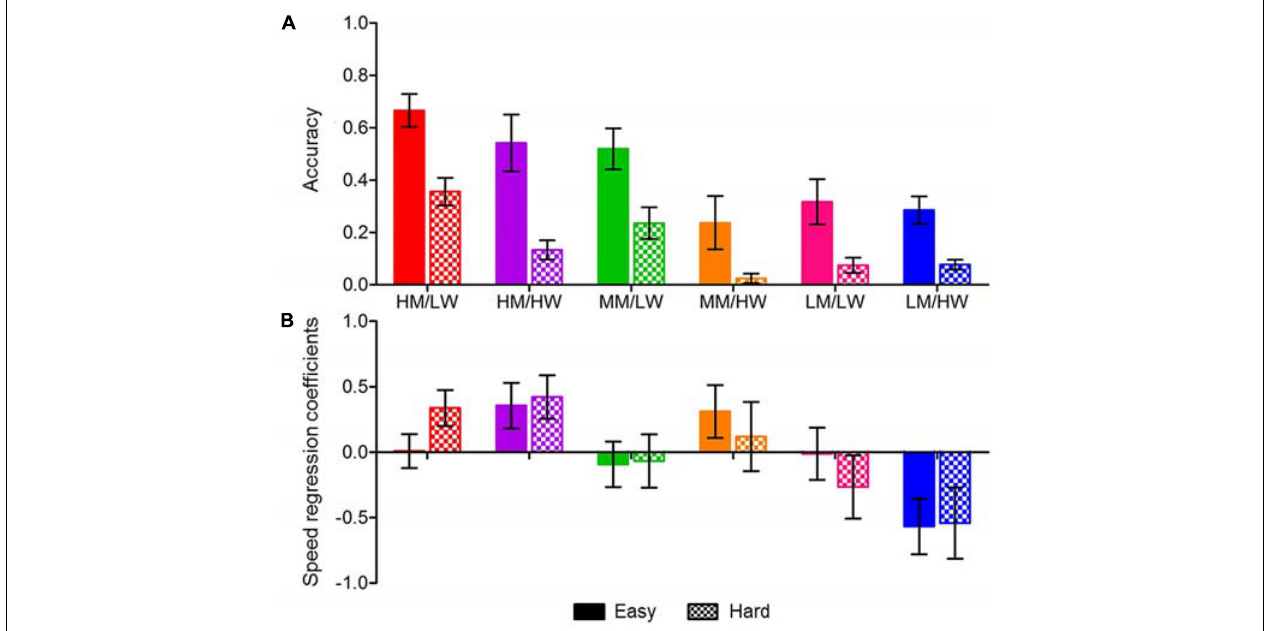
the x -axis indicate faster responses. Error bars represent standard error. Statuses are HM/LW (high WM/low worry), HM/HW (high WM/high worry), MM/LW (moderate WM/low worry), MM/HW (moderate WM/high worry), LM/LW (low WM/low worry), and LM/HW (low WM/high